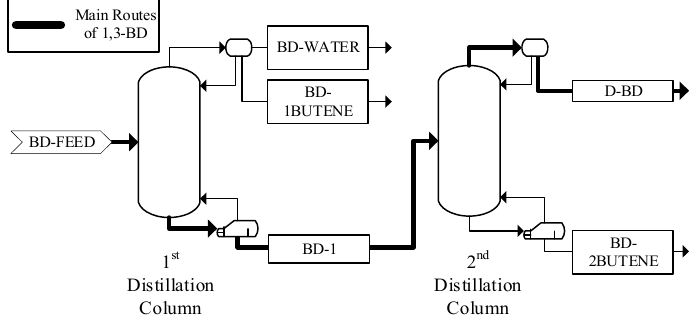
Figure 3. The 1,3-BD purification unit for the conventional distillation process [11].